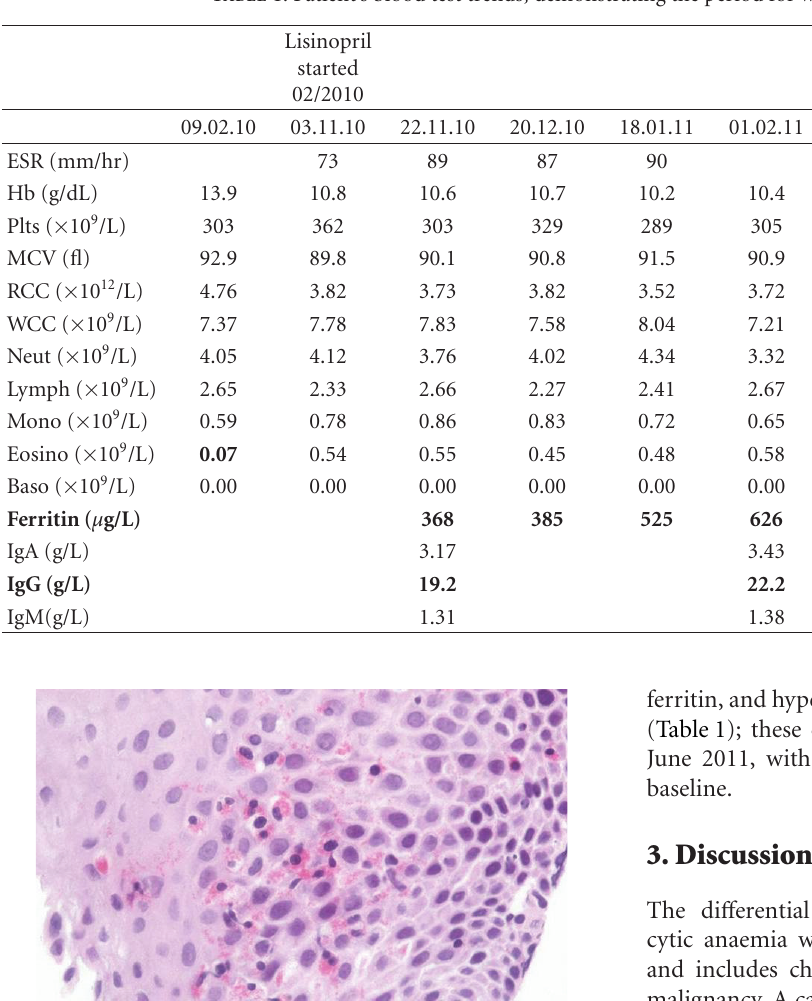
Table 1: Patient’s blood test trends, demonstrating the period for which lisinopril was taken.